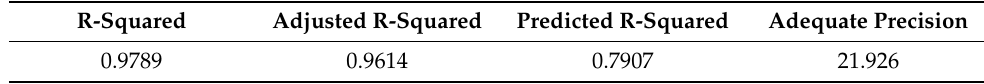
Table 5. The model summary of the quadratic model for the